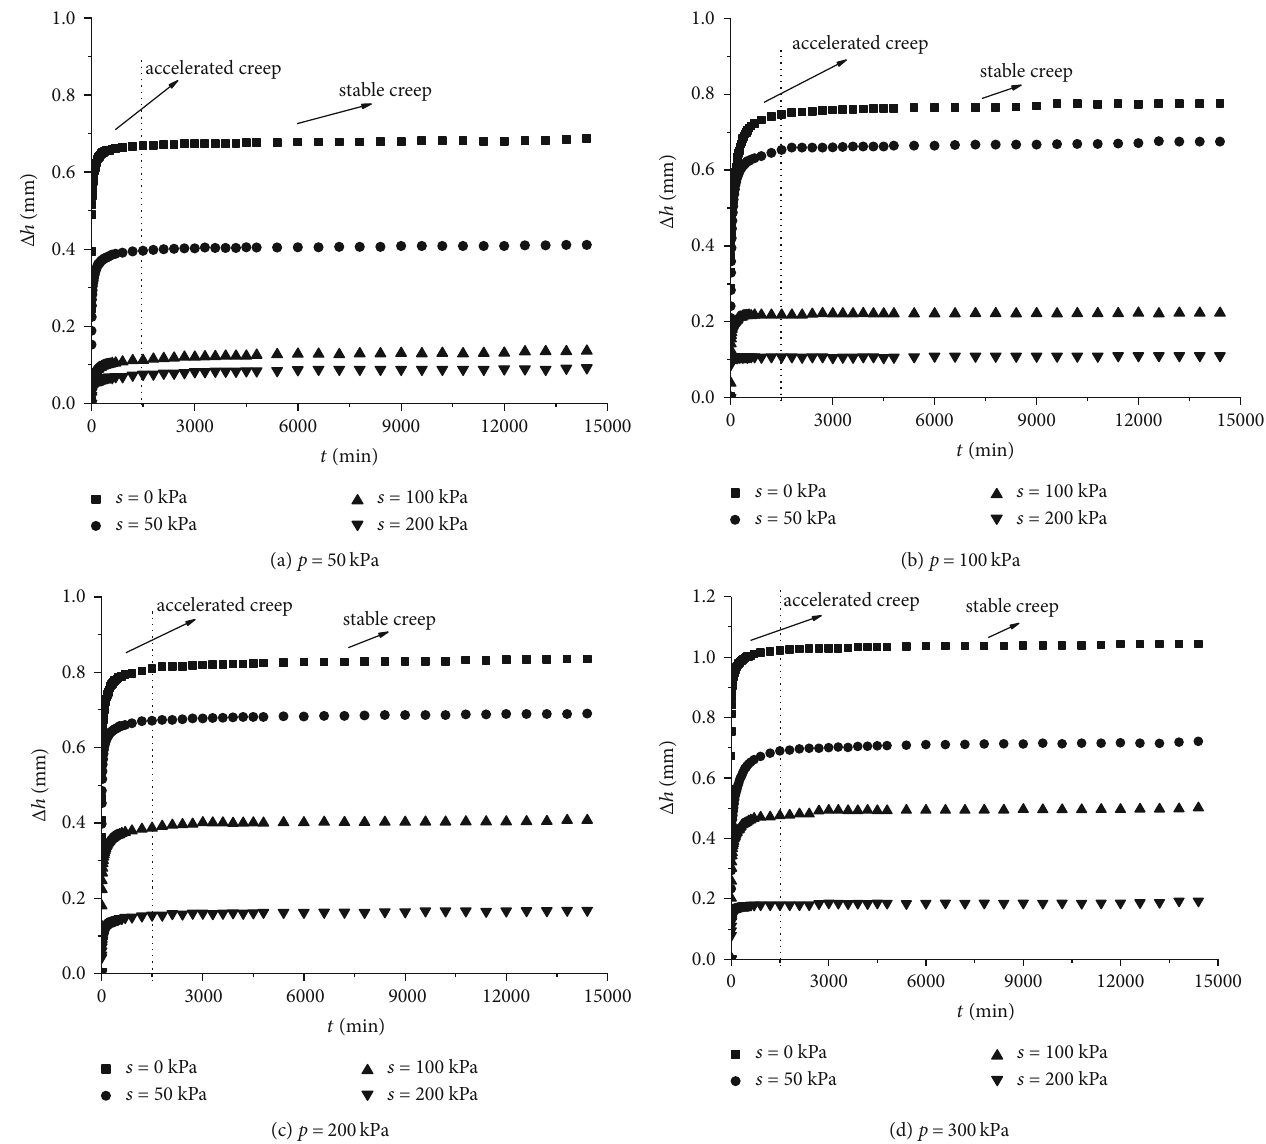
Figure 1: The deformation amount curve for the unsaturated soil samples with di ff erent matric suctions over